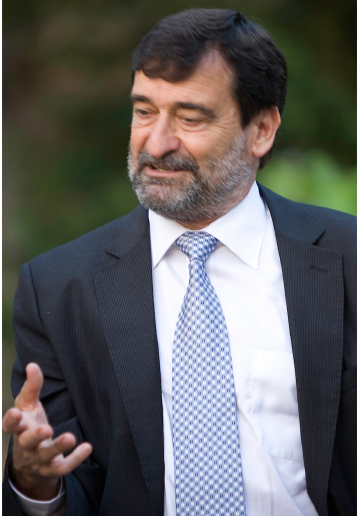
Figure 1. Prof. Andrés